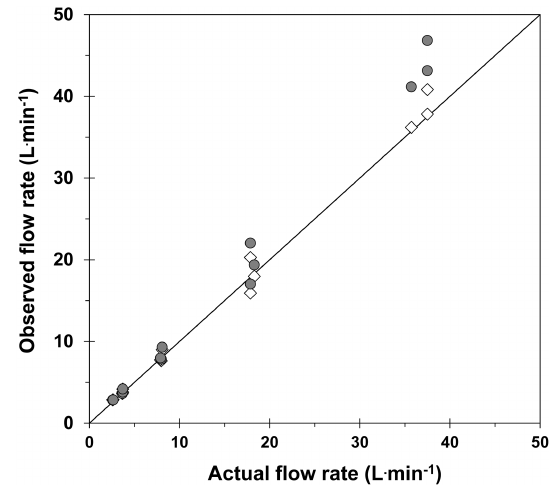
correctedmeasurements are represented by the gray-filled circles, while themeasurements corrected using Eq. (5) are represented by the open diamonds. Each point represents the mean flow rate mea- sured over a 5min